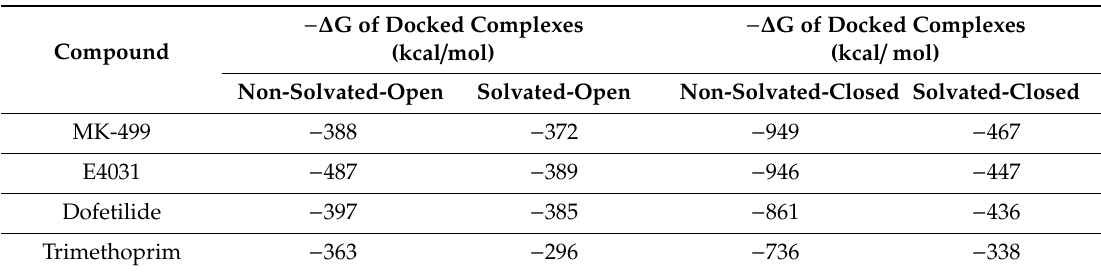
Table 1. Showing energy values ( − ∆ G) of selected inhibitors in non-solvated and solvated docked complexes in open and closed cavity of